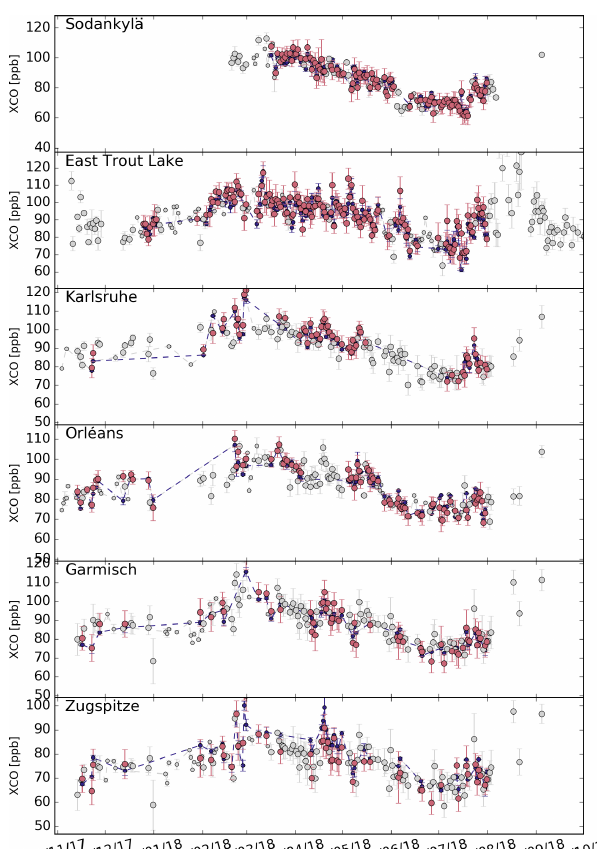
Figure 1. Daily mean of dry air column mixing ratios (XCO) mea- sured by TROPOMI (pink) and various TCCON stations (blue) un- der clear-sky and cloudy atmospheric conditions. A colocation ra- dius of 50km is used. The standard deviation of individual retrievals within a day is shown as an error bar. The retrieval deployed the spectroscopic database HITRAN 2016 for all trace gases. Measure- ments of both datasets that could not be paired are marked as gray dots (big = TROPOMI, small = TCCON) and are not used in this study.